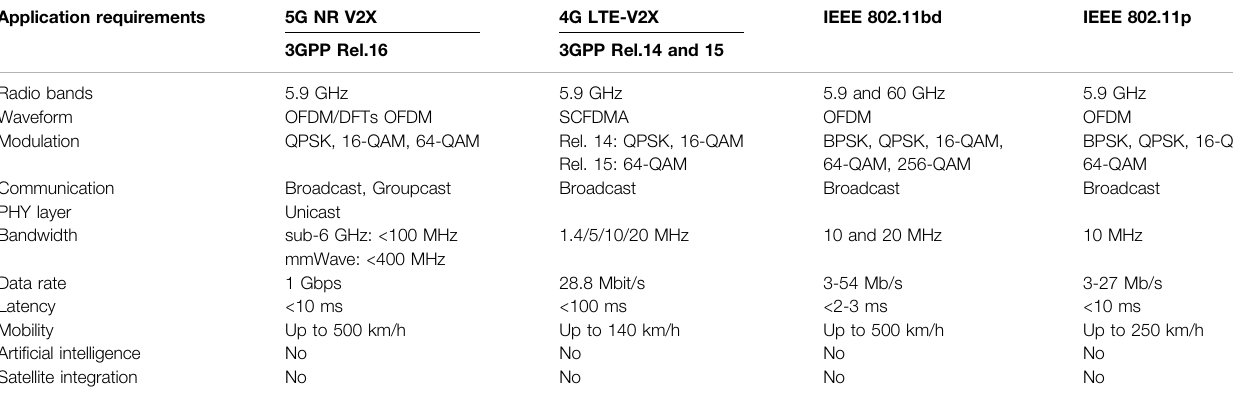
TABLE 2 | Vehicular communication technologies and key performance indicators. Application